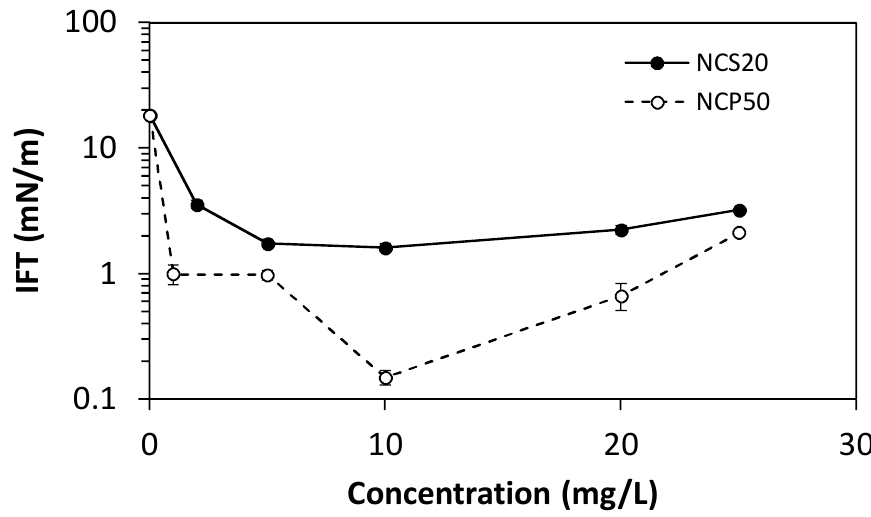
Figure 7. Oil/water interfacial tension in the presence and absence of NCS20 and NCP50 at different concentrations between 1 and 25 mg/L, and at a fixed temperature of 25 °C.